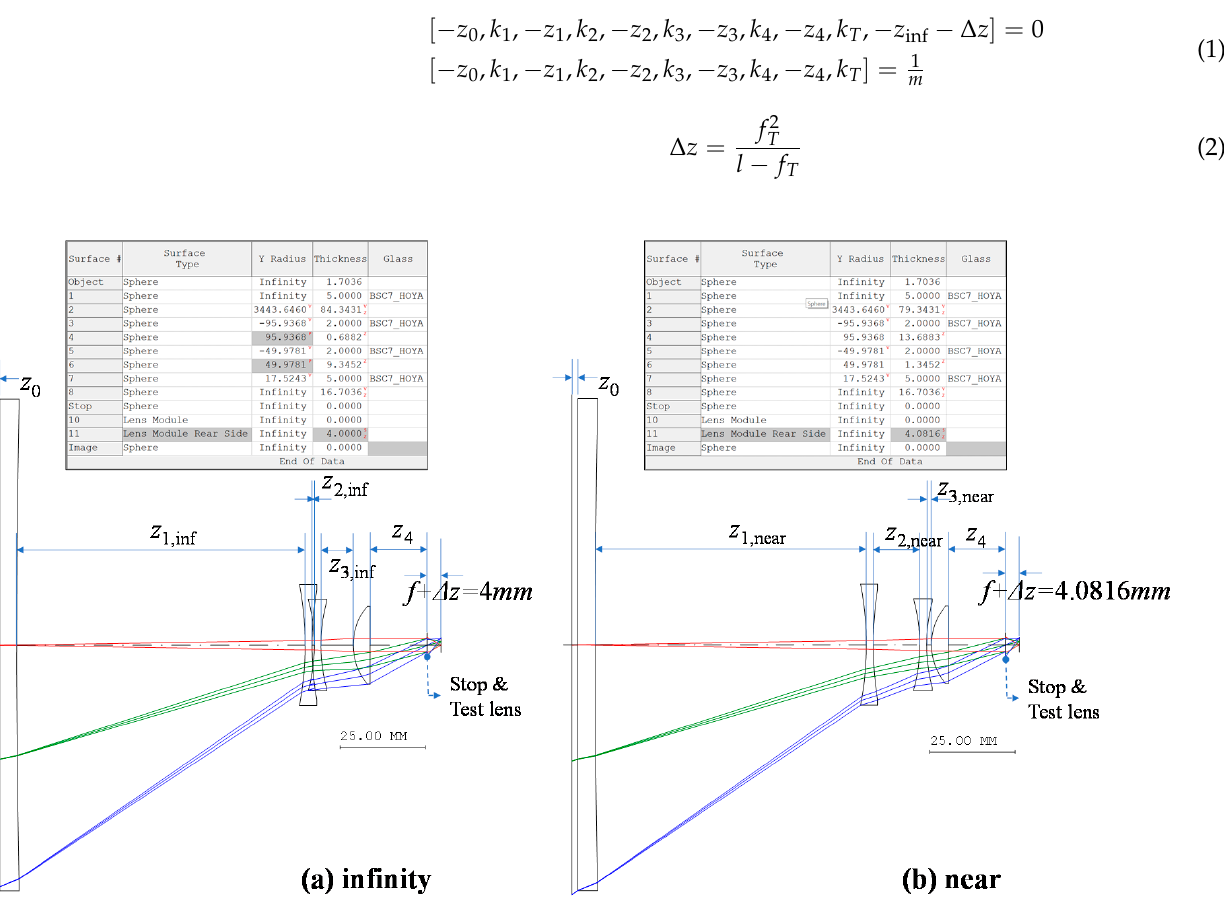
Table 1. The initial distance between lens groups .